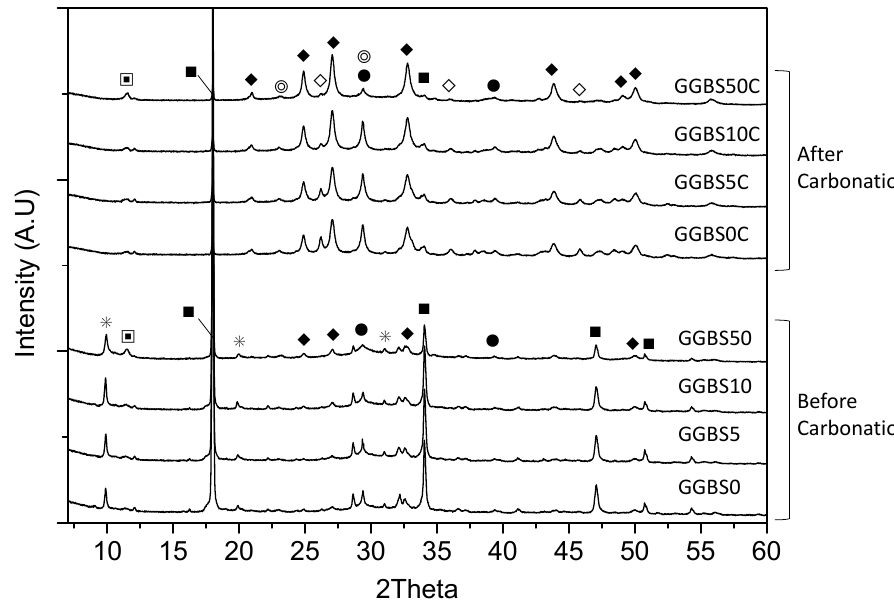
Figure 11. XRD patterns of the GGBS-PC paste with GGBS replacement ratios of 0, 5, 10, and 50 wt % before and after 28 days of accelerated carbonation. ◆ : Vaterite, ♢ : Aragonite, ■ : Ca(OH) 2 , ◎ : Calcite, ● : C-S-H, ✳ : Monosulfate, and ⎕ : Hydrotalcite.